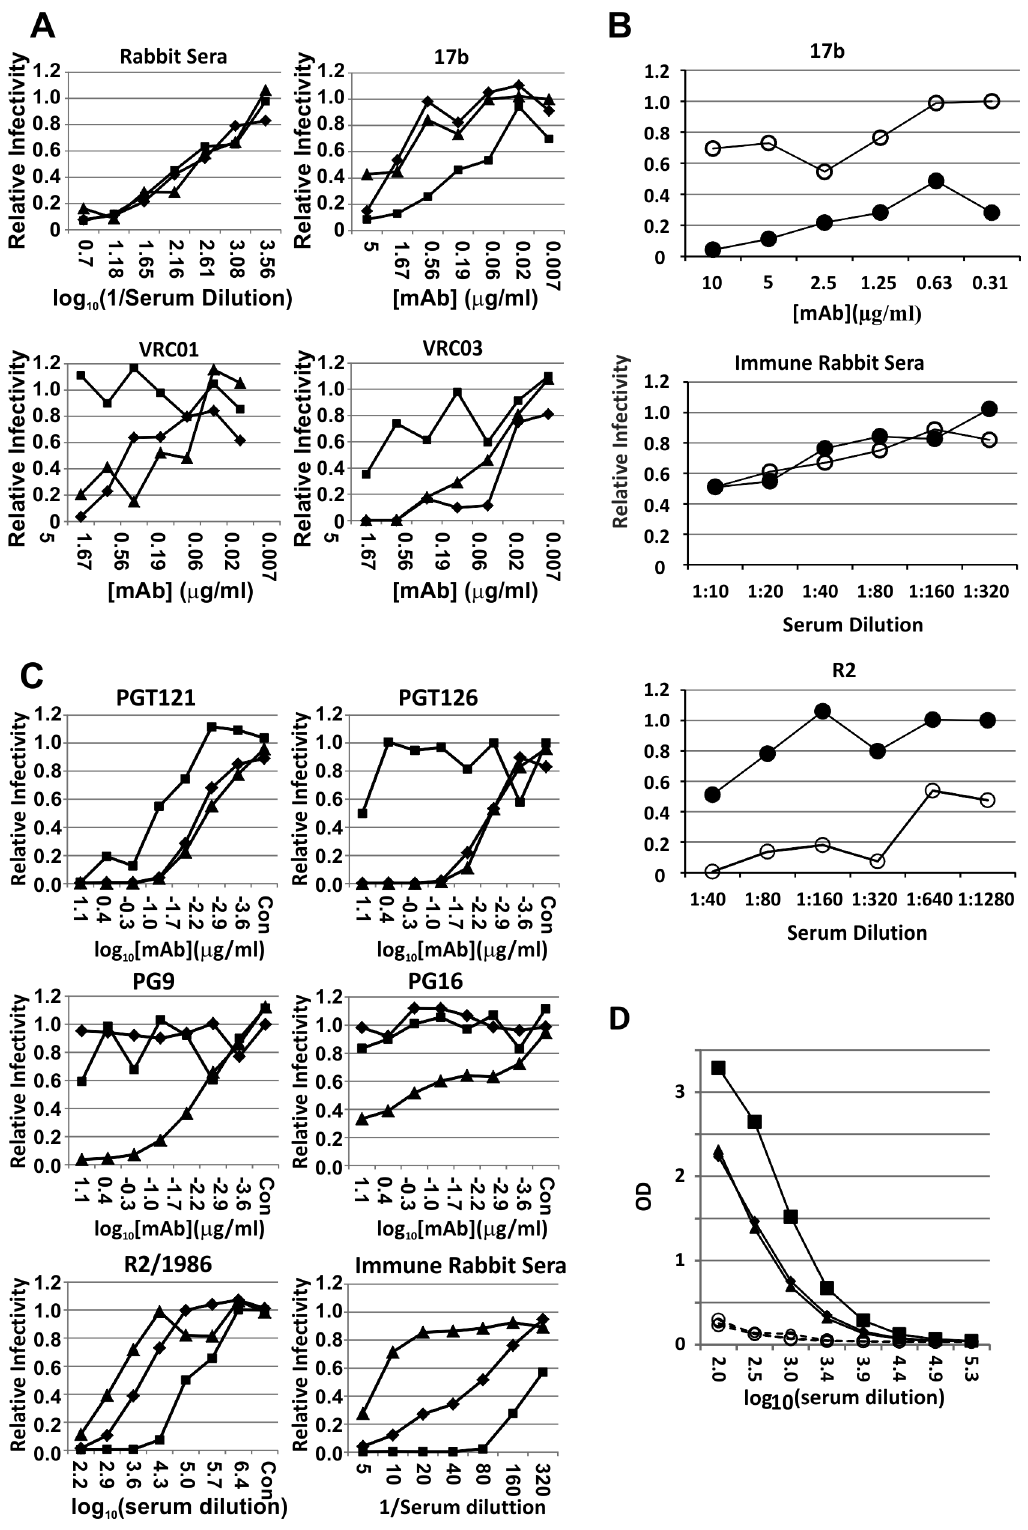
Figure 4. Probing the epitope specificity of neutralizing activity in sera from immunized rabbits. (A) Absence of blocking of neutralization by rabbit sera by the CD4 binding site scaffold RSC3. Neutralization of the R2 strain by post dose seven rabbit sera and mAbs 17b, VRC01, and VRC03 in the presence of medium alone ( X ), RSC3 ( & ), or the CD4bs mutant scaffold RSC3 D 371I ( m ) were compared. Each of the scaffold proteins were incubated with the sera for 1 hr at 37 u C at 50 m g/ml before testing for neutralization. Results are representative of two separate experiments. Neutralization by mAb 17b was enhanced by the presence of RSC3, while neutralization by the CD4bs mAbs VRC01 and VRC03 was effectively abrogated by preincubation with RSC3. (B) Minimal effect of virus pre-binding by sCD4 on neutralization of HIV-2 by immune rabbit sera.